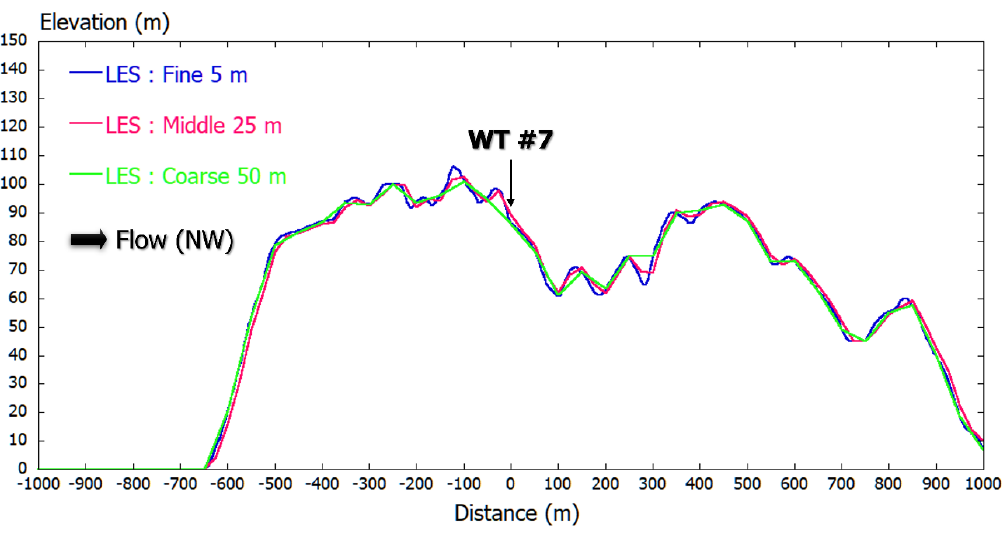
Figure A2. Comparison of terrain shapes passing through WT #7 for north-westerly wind—5 m, 25 m, and 50 m .